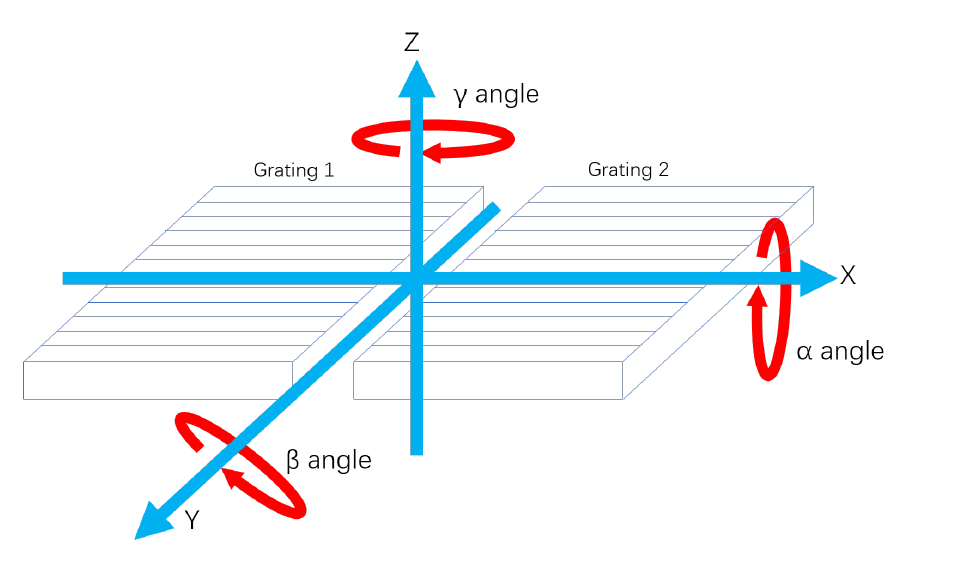
Figure 10. The direction of α , β , and γ angle. Table 1. The Impact of the 3D angle variations.